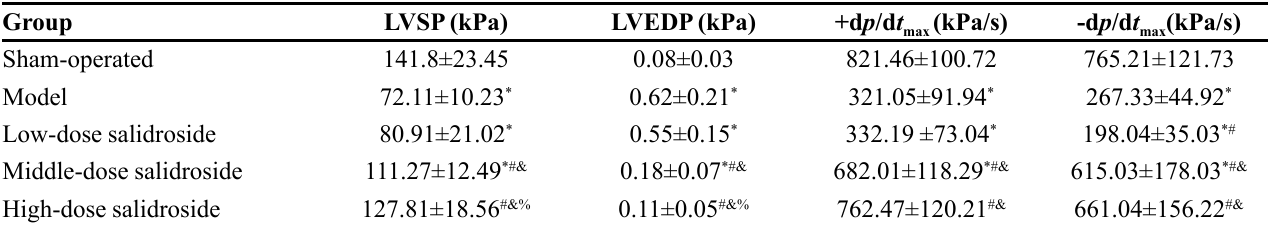
TABLE I - Effects of salidroside on cardiac function of rats Group